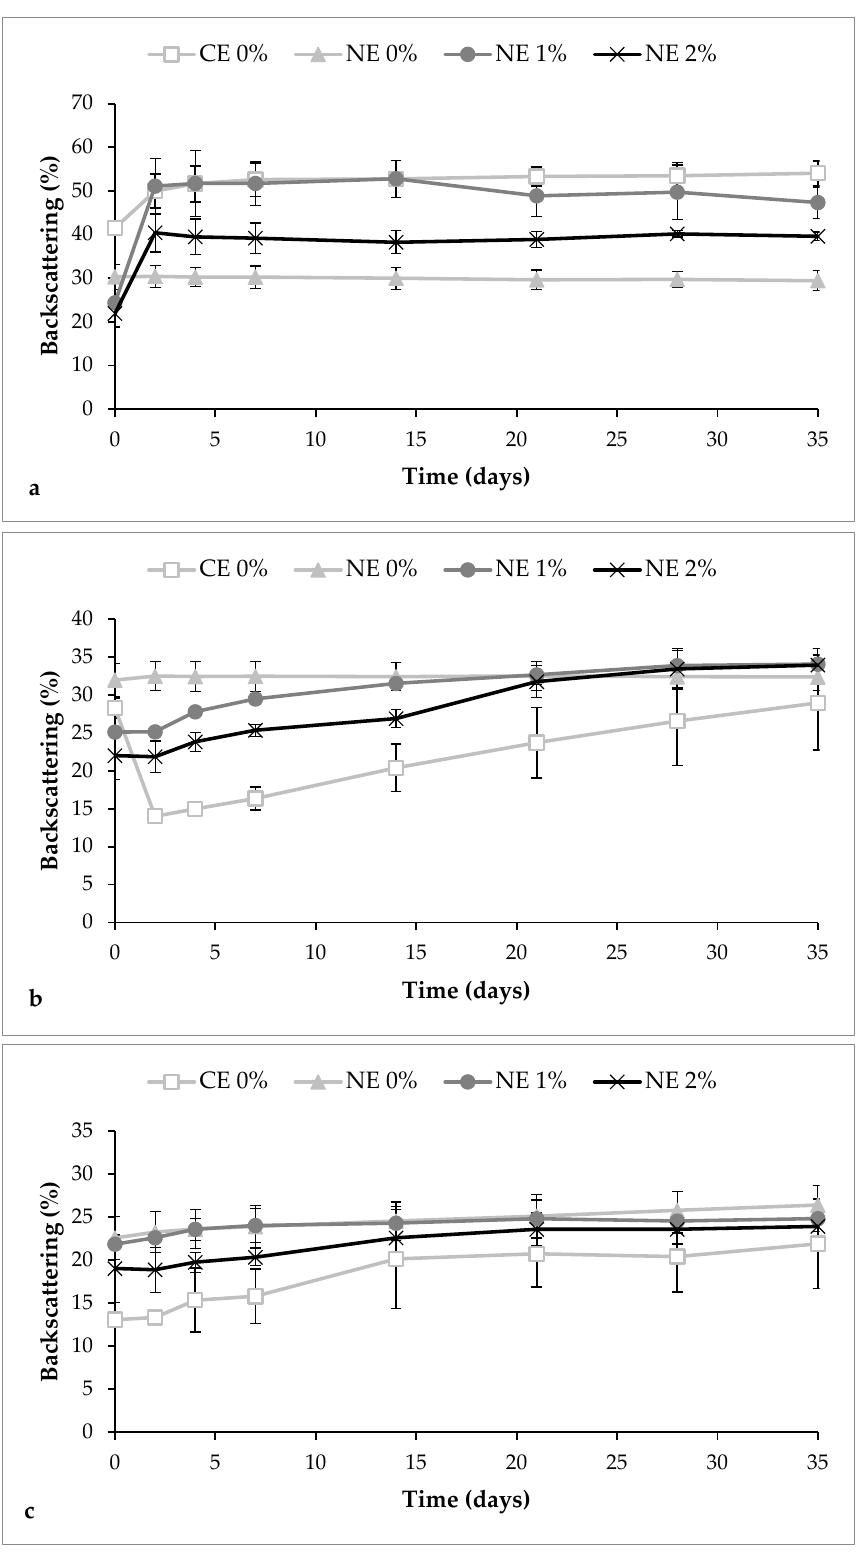
Figure 2. Variation of backscattering values in coarse emulsion and nanoemulsions with different pectin concentrations (0%, 1%, and 2%) at different zones of the test tube during 35 days at 4 °C. ( a ) Top zone; ( b ) Middle zone; ( c ) Bottom zone. CE 0, coarse emulsion without pectin; NE 0 nanoemulsion without pectin; NE 1, nanoemulsion with 1% of pectin; NE 2, nanoemulsion with 2% of pectin.